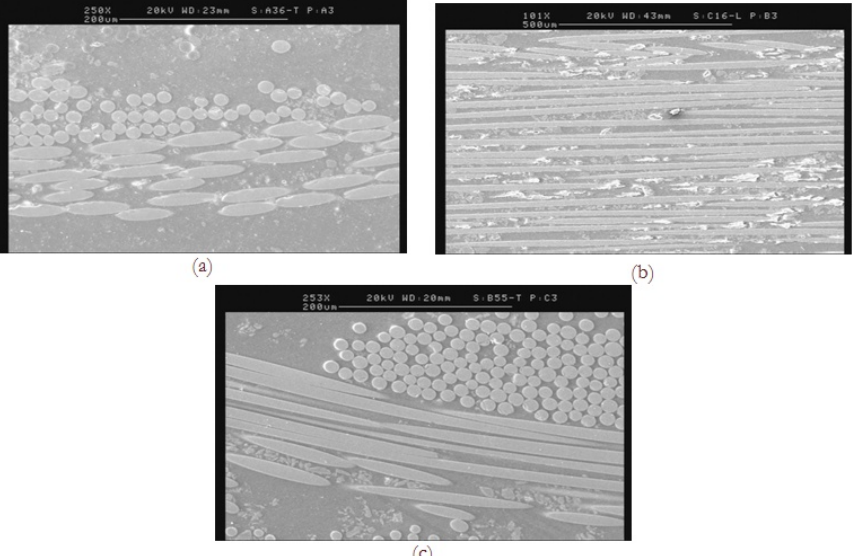
Figure 4: SEM micrographs of Mat (a), Roving (b) and Volumat (c) layers.